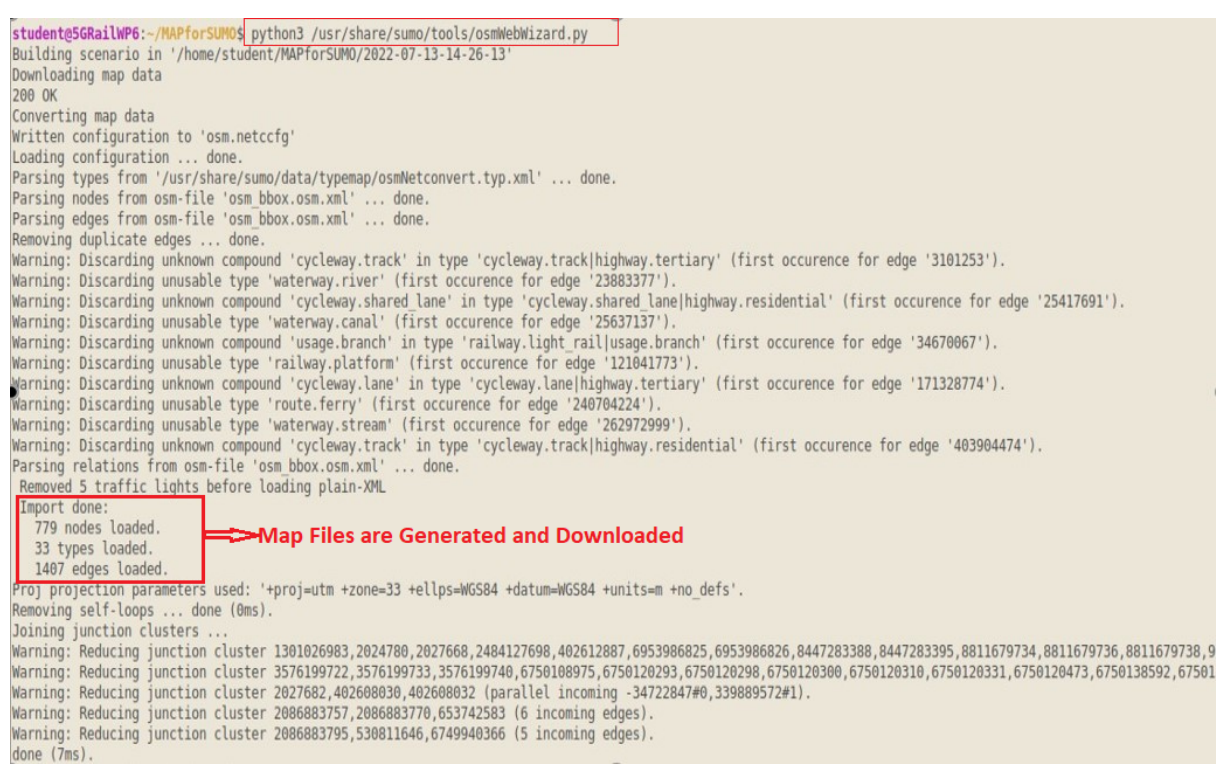
Figure 41. Selected map: Puente de Santiago.